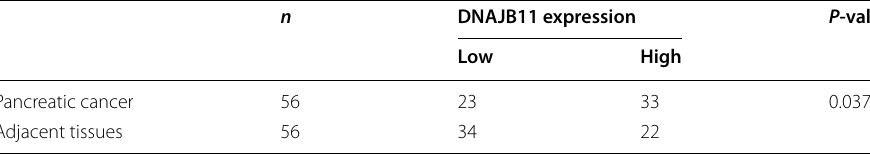
poorer OS than those with low expression of DNAJB11 ( P < 0.009). To study the prog- nosis-related factors, we used multivariate Cox regression. The results showed that the expression of DNAJB11 was an independent risk factor for PC (Fig. 2G). The high